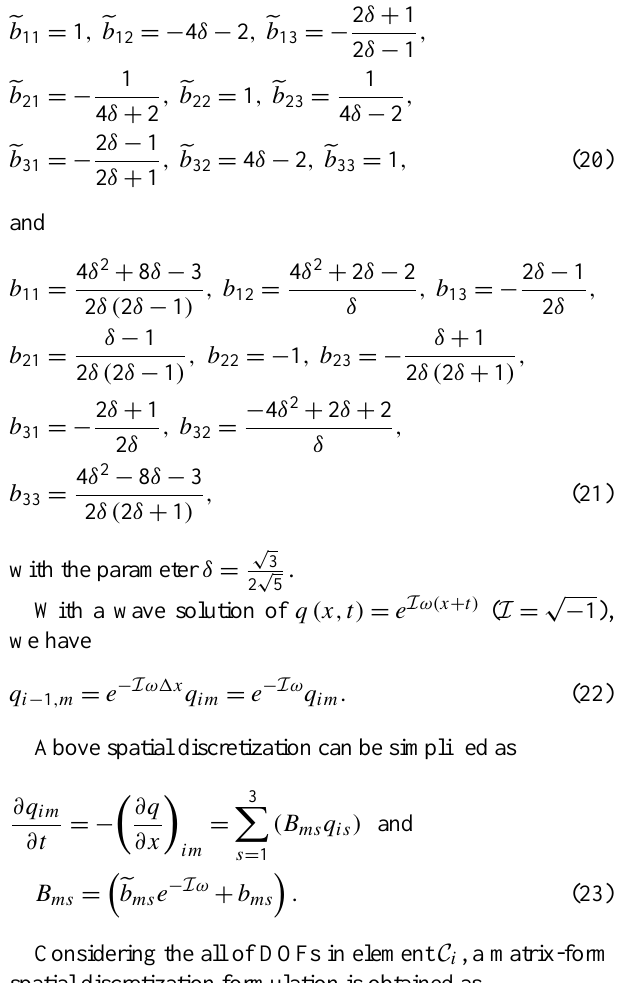
Figure 2. The spectrum of the semi-discrete scheme.